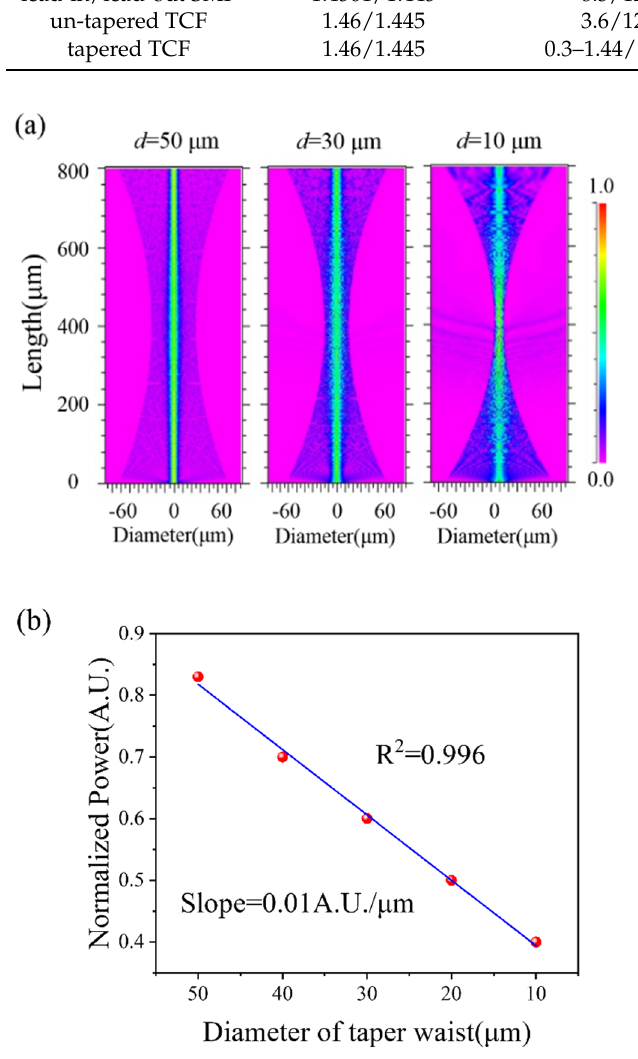
Figure 2. ( a ) Light field distributions of t -TCF structure and ( b ) normalized power with a varied diameter of taper waist.